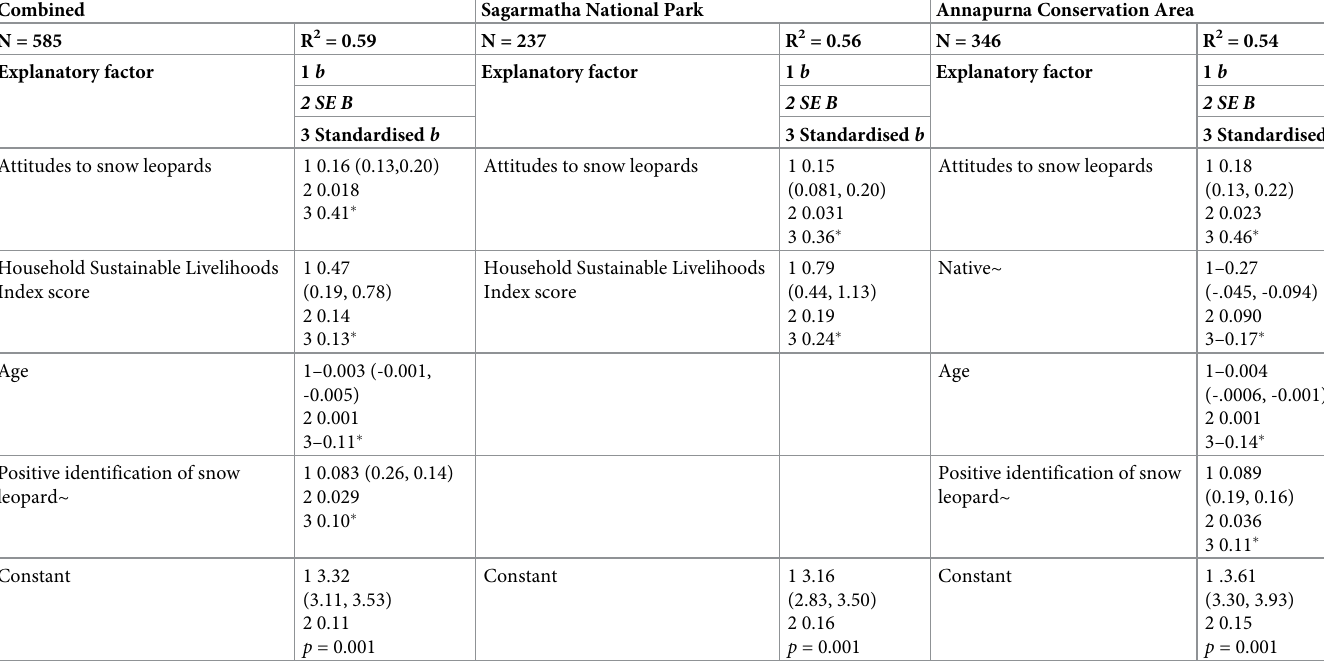
Table 6. Factors best explaining attitudes to snow leopard conservation in Sagarmatha National Park, in Annapurna Conservation Area and for a combined sample. Combined